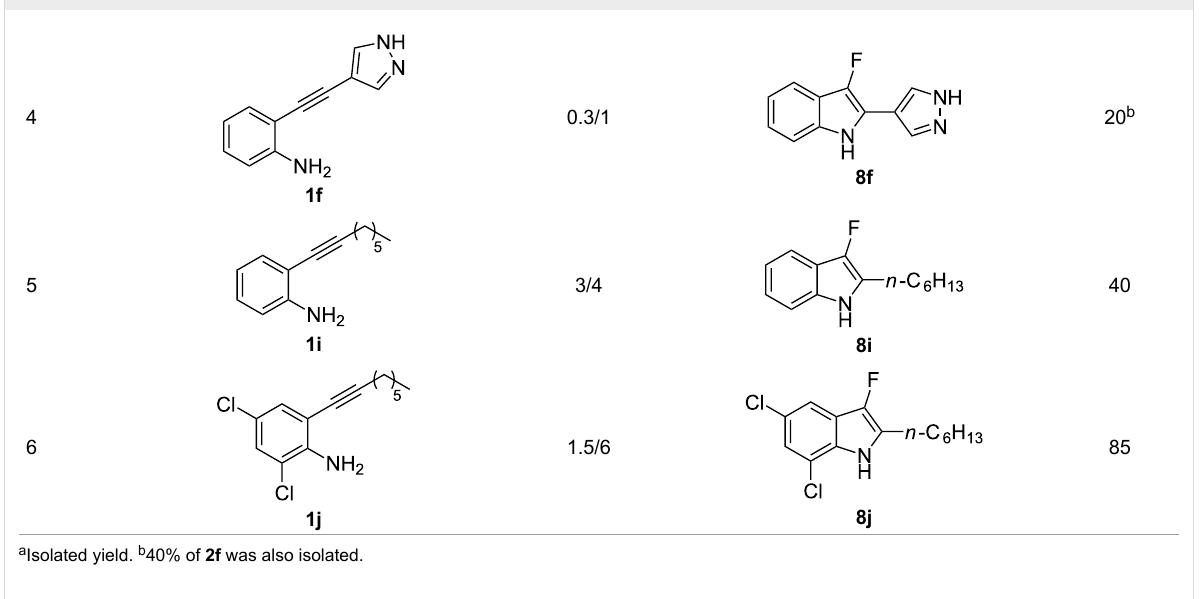
Table 3: Cycloisomerization/fluorination reaction of 2-alkynyl-substituted anilines.